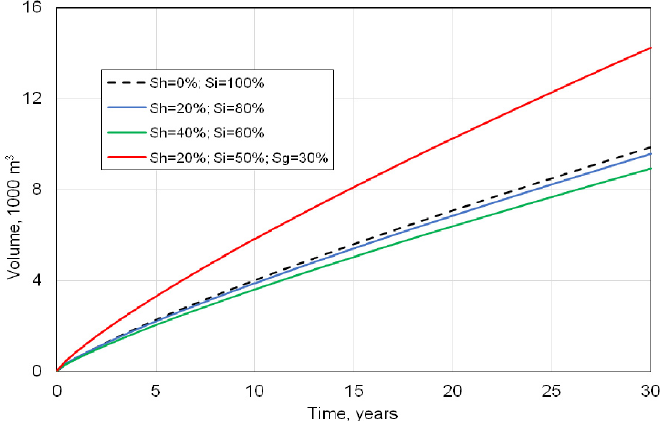
Figure 11. Time-dependent thaw variations in the 60 ‒ 120 m depth interval at different hydrate saturation values. 𝑆 (cid:3035) , 𝑆 (cid:3036) , and 𝑆 (cid:3034) refer to hydrate, ice, and gas (methane) saturation, respectively. Pore gas hydrates turned out to only slightly affect the thawing rate; the thawing of permafrost with 𝑆 (cid:3035) = 20% was <5% slower than in the absence of hydrates. This, appar- ently, unexpected result may be due to the starting conditions of about − 5°C permafrost temperature and 𝑆 (cid:3035) = 20% chosen according to field and laboratory experimental evi- dence from the Bovanenkovo field. The thawing was only slightly slower also at 𝑆 (cid:3035) = 40% and 𝑆 (cid:3035) + 𝑆 (cid:3036) = 100%. As shown by more detailed studies, the effect of the hydrate compo- nent on the thawing rate is additionally controlled by thermal conductivity, which is in- versely proportional to the hydrate saturation and initial permafrost temperature. On the other hand, thawing decelerated due to heat flux toward colder rocks. However, these issues require special consideration and are planned to be the subject of a separate study. As predicted by the model, methane emission from permafrost that contained 20% of metastable pore gas hydrates could reach 400,000 to 500,000 m 3 after 30 years of gas production, corresponding to a daily emission of 50 m 3 (Figure 12). Figure 12. Potential methane emission from gas hydrate-bearing permafrost (60 ‒ 120 m depth inter- val) associated with well–permafrost interaction at different hydrate saturation values. 𝑆 (cid:3035) , 𝑆 (cid:3036) , and 𝑆 (cid:3034) refer to hydrate, ice, and gas (methane) saturation, respectively. The amount of methane emission from hydrate-bearing permafrost exposed to warming upon the interaction with petroleum wells depends on the thaw size, as well as on the temperature and saturation (with hydrate and ice) of permafrost around the casing. The saturation, in turn, affects the thawing rate of permafrost via its thermal properties.